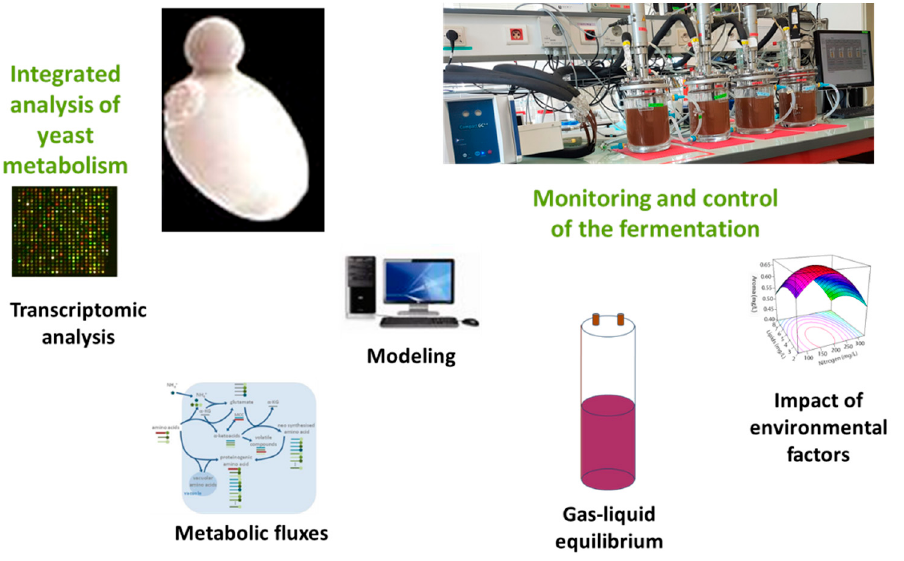
Figure 4. Integrated approach combining biochemical engineering and system biology. Example of fermentative aroma synthesis. Online monitoring and fermentation control tools make it possible to (i) carry out cultures under perfectly controlled conditions; (ii) monitor parameters of metabolic interest: fermentation rate, and synthesis dynamics of the main fermentative aromas (with total production, i.e., concentration in the liquid + losses); (iii) cross-reference this information with system biology approaches: choice of key moments for post-genomic analyses and comparison of metabolic flux estimates (production rates vs. flux modelling).